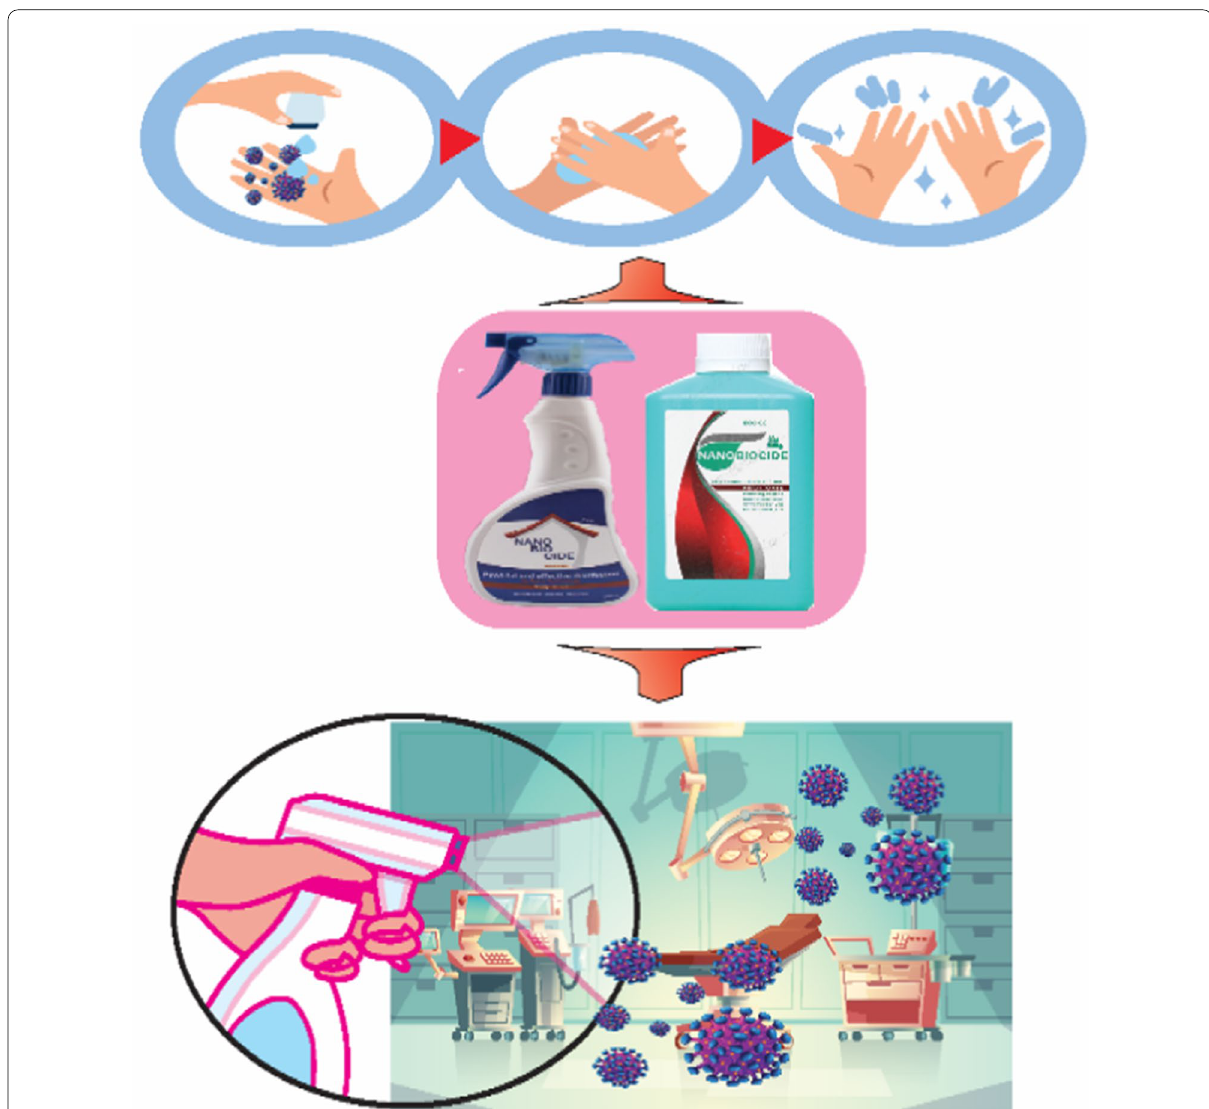
Fig. 3 The application of nanobiocides as the sanitizer and disinfectant for hand washing and healthcare